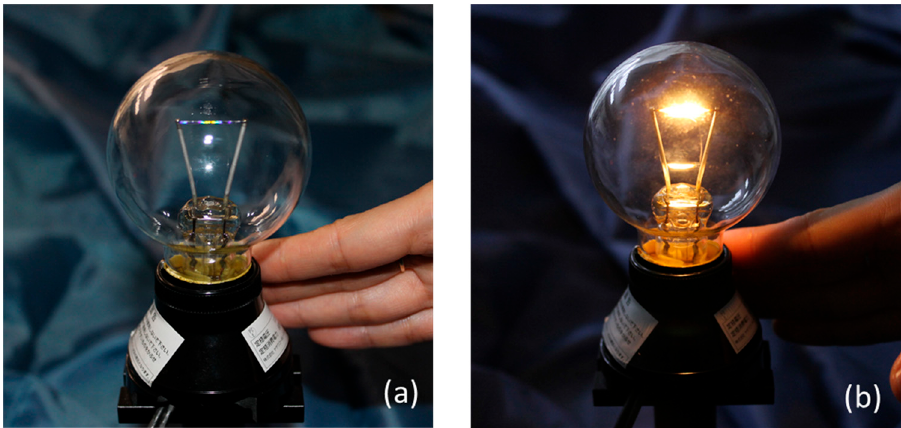
Figure 5. A prototype of the microcavity lamp: ( a ) turning off and ( b ) on.